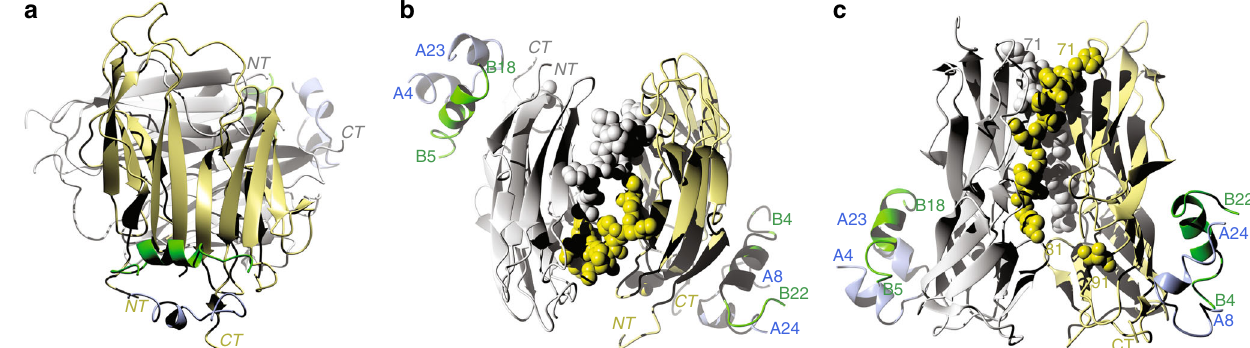
Fig. 6 Organisation of the holo-Imp-L2 dimer in complexes with DILP5 and IGF-1. Only DILP5 complex is shown as a representative example. Each individual Imp-L2 molecule is in white and yellow, DILP5 B-chain in green and A-chain in blue. a The general arrangement of the holo-dimer in a view similar to as in Fig. 3a and 4a. b A close-up on the inter-monomer interface in holo-dimer after ~90° rotation along horizontal axis of the dimer shown in a . c A close-up on the inter-monomer interface in holo-dimer after 90° rotation along vertical axis of the dimer shown in a . The 70 – 92 loops of each dimer shown in Van der Waals spheres, and coloured correspondingly to their